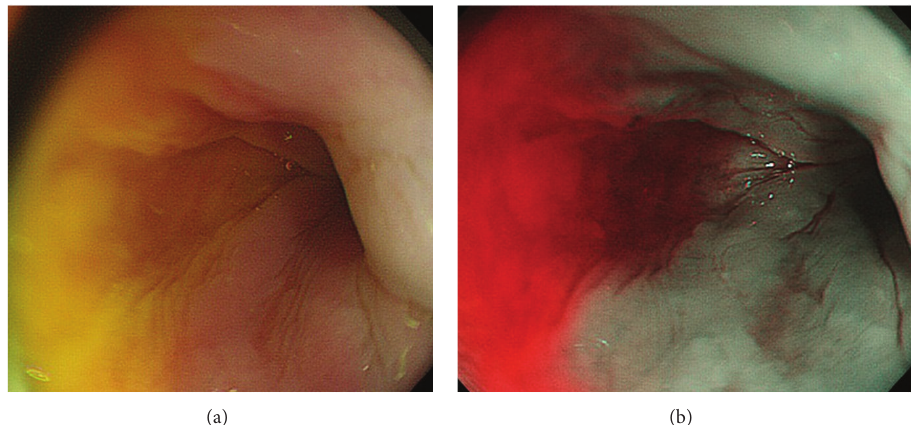
Figure 1: DGERD during esophagoscopy; note how severe the bile reflux appears on NBI (b) compared with correspondent white light image